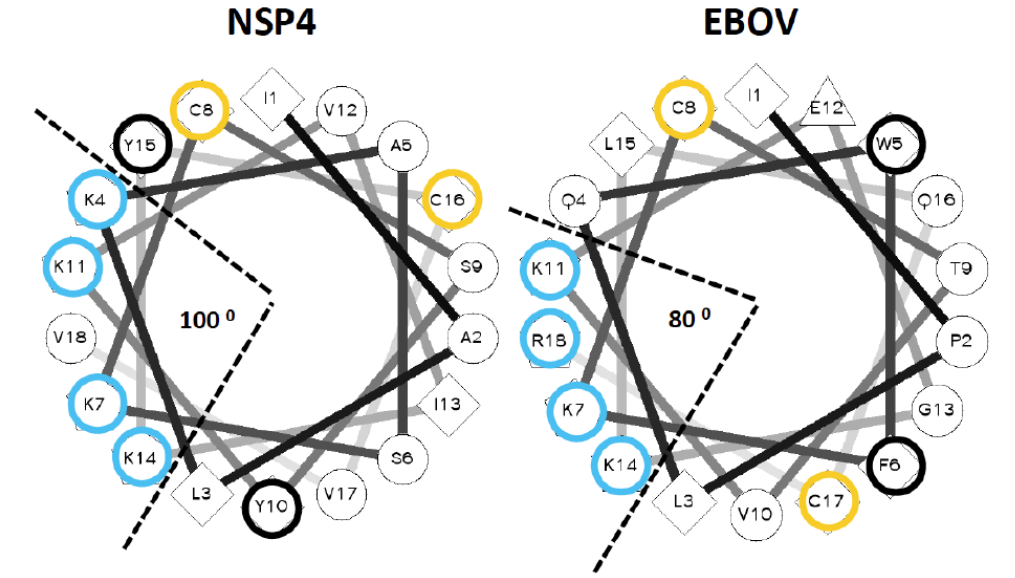
Figure 1. Helical wheel projections for the lytic peptide of NSP4 protein of Rotavirus and the carboxy-terminal half of Ebola virus delta peptide. An online utility was used to project NSP4 and carboxyl terminal amino acids of EBOV delta peptide as an alpha helix [34]. The applet also computes the value and angular direction of hydrophobic moment of each peptide. For emphasis, lysine and arginine residues are circled in blue, cysteine residues in yellow, and aromatic residues in